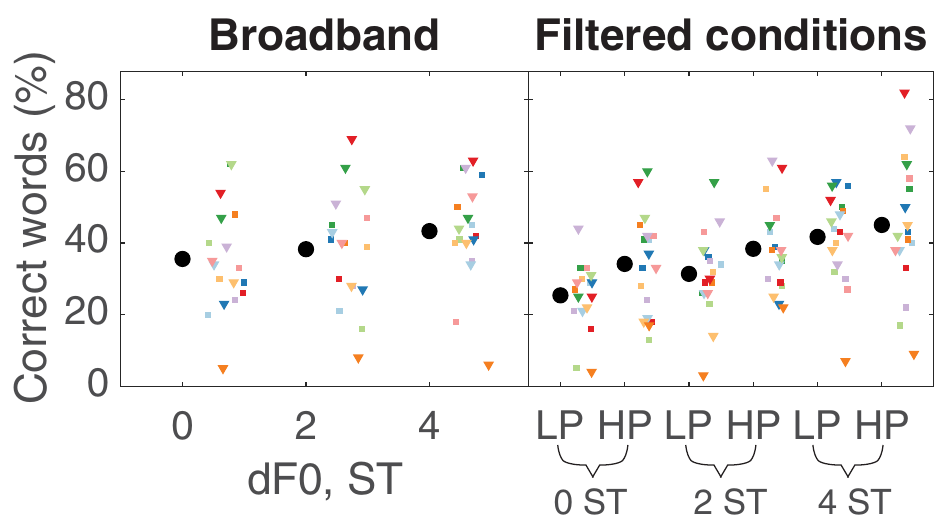
Fig 2. Results for the speech experiment. Speech scores for the broadband condition (left panel), and the lowpass- and highpass-filtered conditions (right panel). Larger black circles represent the mean across participants and the smaller colored symbols show the individual